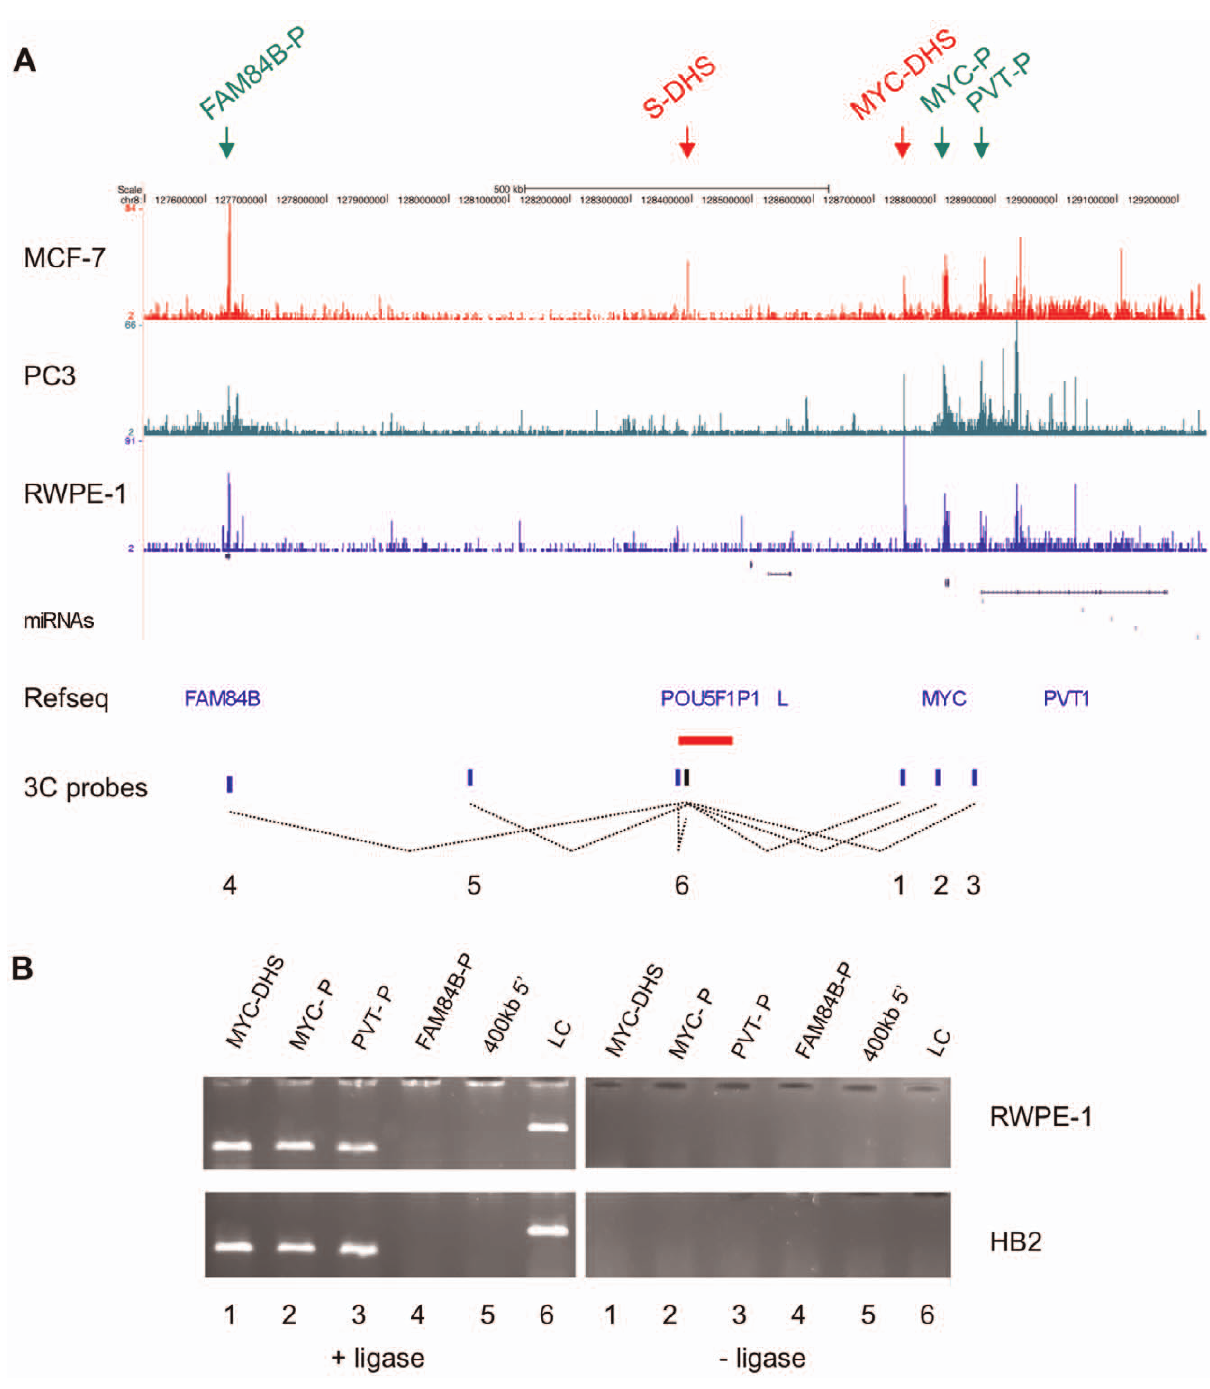
Figure 1. Chromatin conformation at the 8q24 locus. (A) DNase-seq track for the breast cancer cell line MCF-7, the prostate cancer cell line PC3 and the normal-like prostate cell line RWPE-1 displayed on the UCSC genome browser for a 1.7 MB region (chr8: 127,550,000-129,250,000) surrounding the 8q24 cancer susceptibility region, where peaks indicate regions of increased sensitivity to digestions with DNase I. Reads were adjusted for the total number of reads in each experiment. DHSs and promoters used in subsequent analysis are marked by arrows. RefSeq genes are shown, with L being LOC727677. The prostate and breast cancer susceptibility region is depicted by a horizontal red bar. Dotted lines show interactions tested in the chromatin conformation capture experiment shown in (B). (B) Chromatin conformation capture (3C) experiment using the S-DHS as bait in the HB2 breast and the RWPE-1 prostate cell lines. Target sequences are indicated above the lanes. A target sequence just upstream of the Eco RI site 5 9 to the bait Eco RI site was used as ligation control (LC). Negative controls for each ligation reaction were cut but unligated DNA fragments. The numbers below the panel refer to interactions shown in (A).